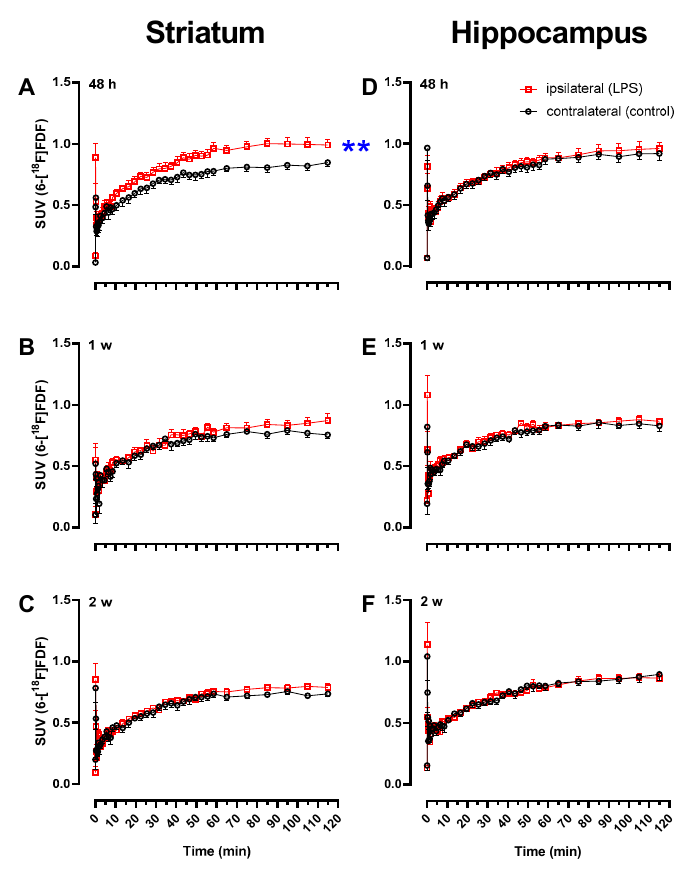
Figure 2. Time–activity curves (TACs) of 6-[ 18 F]FDF in striatum and hippocampus of rats injected unilaterally with lipopolysaccharide (LPS) in the right striatum. Average TACs ( ± SEM) of 6-[ 18 F]FDF are shown in combined male and female rats in the ipsilateral and contralateral side of striatum ( A – C ) and hippocampus ( D – F ) at 48 h (n = 4M/3F), 1 week (n = 2M/3F), or 2 weeks (n = 2M/3F), post-LPS injection. ** p = 0.003, right vs. left striatum at 48 h (repeated measures ANOVA). With the left-brain region as the reference, the binding potential (BP) on the right side was estimated with simplified reference tissue model (SRTM) [50]. As shown in Figure 3A, one-way ANOVA showed significant change of BP with time in LPS injected striatum ( F 2,14 = 7.68, p = 0.006), with significantly higher BP at 48 h (0.19 ± 0.11) compared to later time points. In preliminary analysis comparing male and female rats, a two-way ANOVA showed a significant effect of sex ( F 1,11 = 7.9, p = 0.017) and time ( F 2,11 = 10.3, p = 0.003) but not sex x time interaction ( F 2,11 = 1.57, p = 0.25), suggesting that male rats (0.25 ± 0.03; n = 4) had significantly higher BP in the ipsilateral striatum than the females (0.11 ± 0.03; n = 3) at 48 h after LPS injection but the response was later diminished with time in both sexes (Figure 3A, inset).